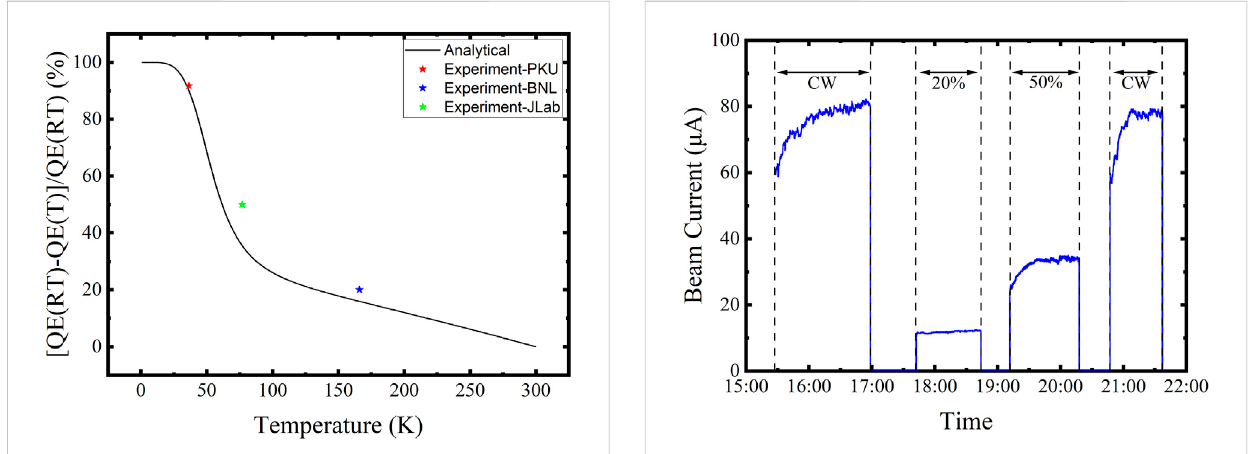
FIGURE 3 Calculated relative QE drop at 519 nm of K-Cs-Sb in DC-SRF photoinjectorcomparedtoroomtemperature;stardotsrepresentthe experimental results. The blue [13] and green [20] dots were reported by other laboratories with an extraction voltage of less than 300 V; therefore, the discrepancies might originate from the differences in work function and the lack of the Schottky effect.